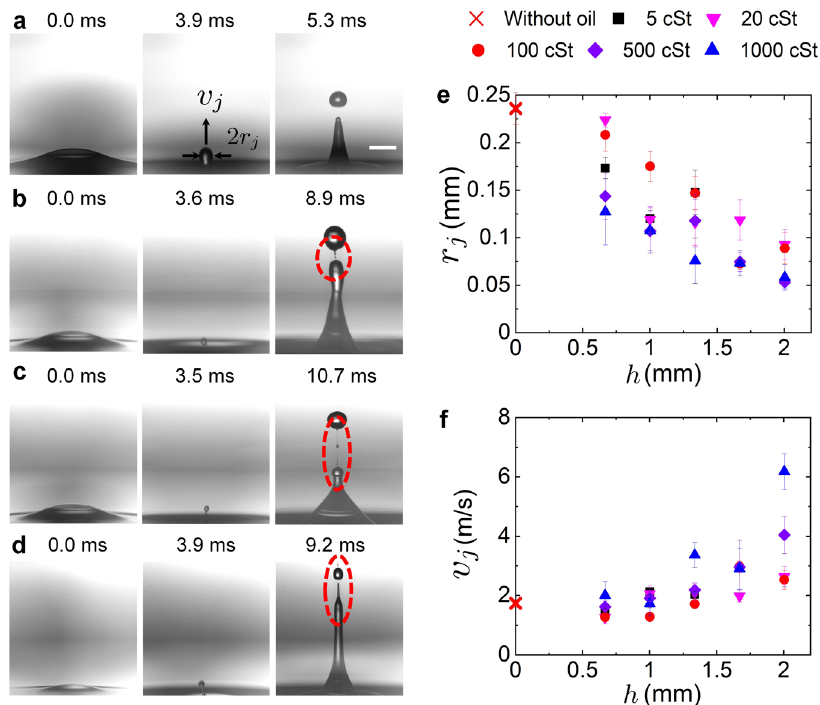
Fig. 2 Snapshots of bubble bursting jetting and the measured jet tip radius and velocity. Side-view snapshots of jet formation during bubble bursting at the aqueous surface ( a ) without an oil layer, and covered by a layer of ( b ) 5 cSt silicone oil, h / R = 0.6, ( c ) 500 cSt silicone oil, h / R = 0.6, and ( d ) 500 cSt silicone oil, h / R = 1.2. R = 1.67 mm in the experiments. Scale bar = 1 mm. t = 0 represents the beginning of bubble bursting when a hole nucleates in the bubble cap. An oily jet is generated (column 2 of a – d ) following the cavity collapse, which becomes smaller but faster with the increasing viscosity and thickness of the oil layer. A thin oily thread is observed in all oily cases (highlighted in column 3 of b – d ). Dependencies of ( e ) the jet tip radius r j and ( f ) jet tip velocity v j on the oil layer thickness h for different oil viscosities. r j and v j are measured when the jet tip crosses the undisturbed air – oil interface. Error bars are calculated as the standard deviations of data of at least 10 runs.